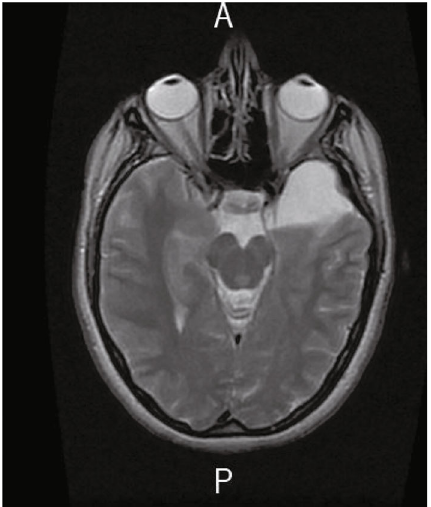
Figure 1: Axial T2-weighted view showing the big temporobasal arachnoid cyst communicating with the basal cisterns (Galassi II).